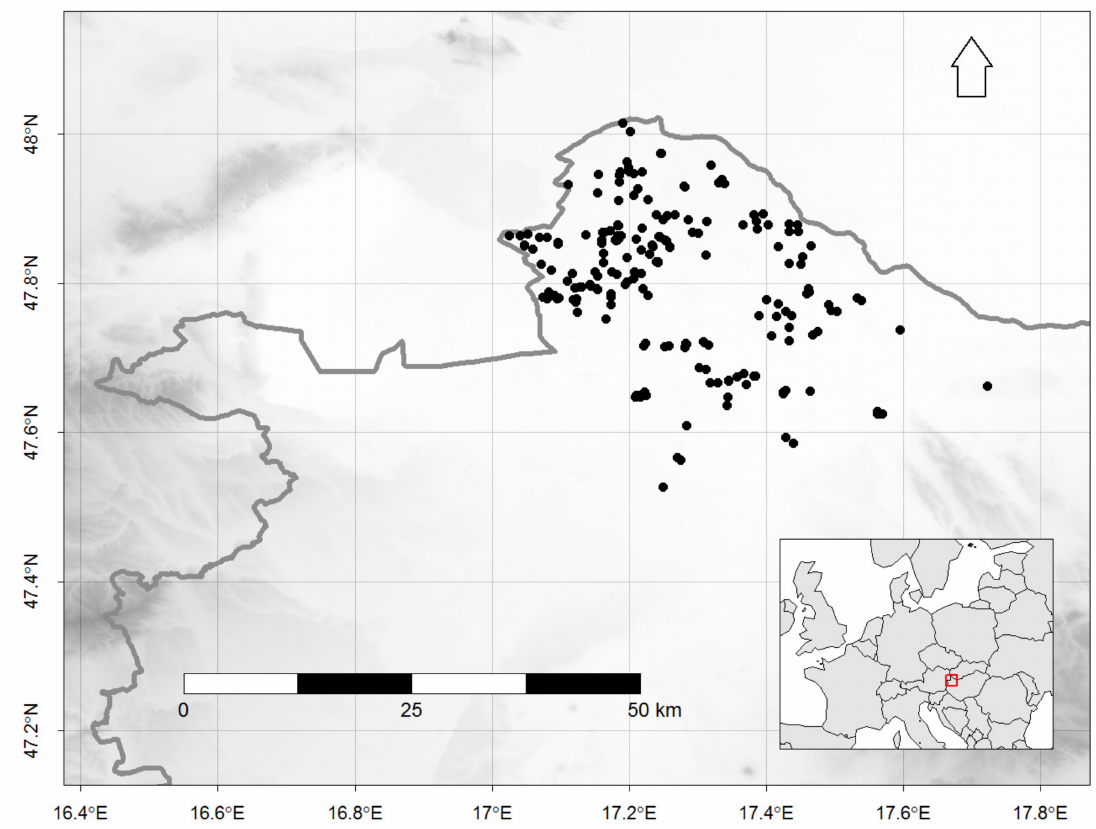
Figure 1. The distribution of the 205 surveyed phacelia fields across the region (a single point may represent multiple